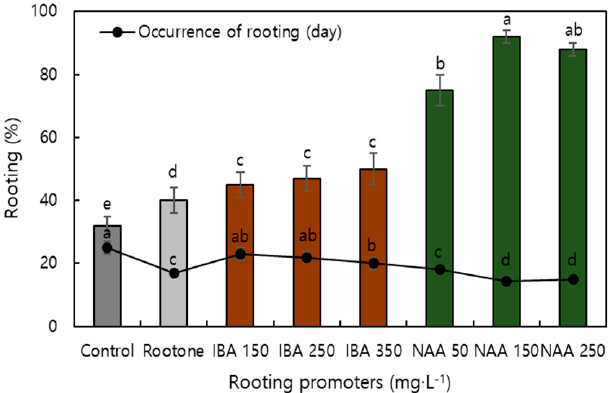
Figure 1. Percentage and average occurrence of rooting in Rhododendron micranthum Turcz. under rooting promoters. Error bars indicate standard errors (n = 10). Different letters indicate significant differences between treatments according to Duncan’s multiple range test ( p ≤ 0.05).